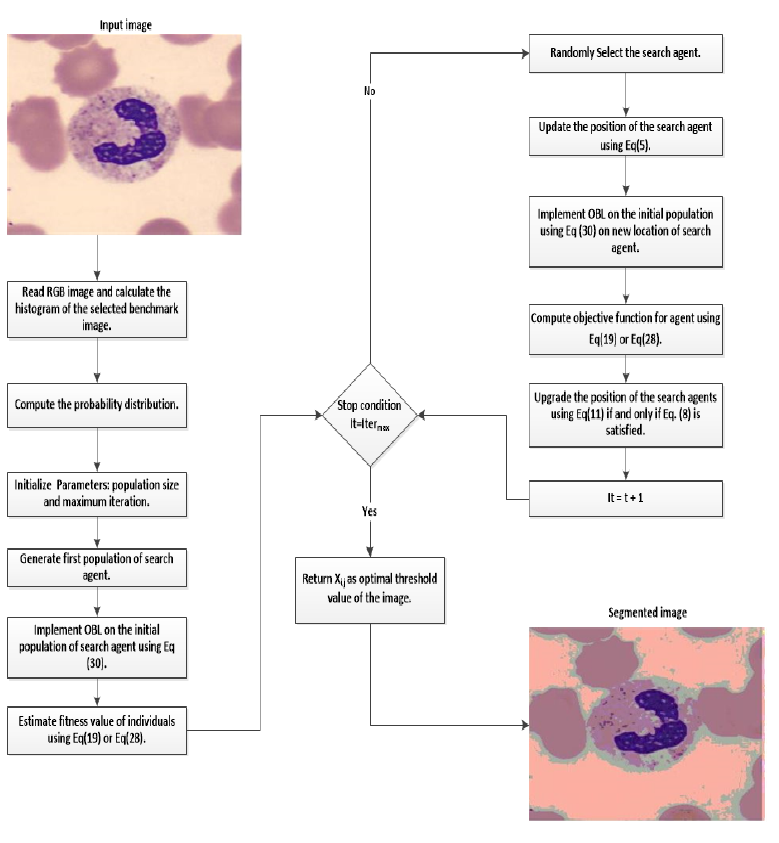
Figure 2. The flowchart of mSAR